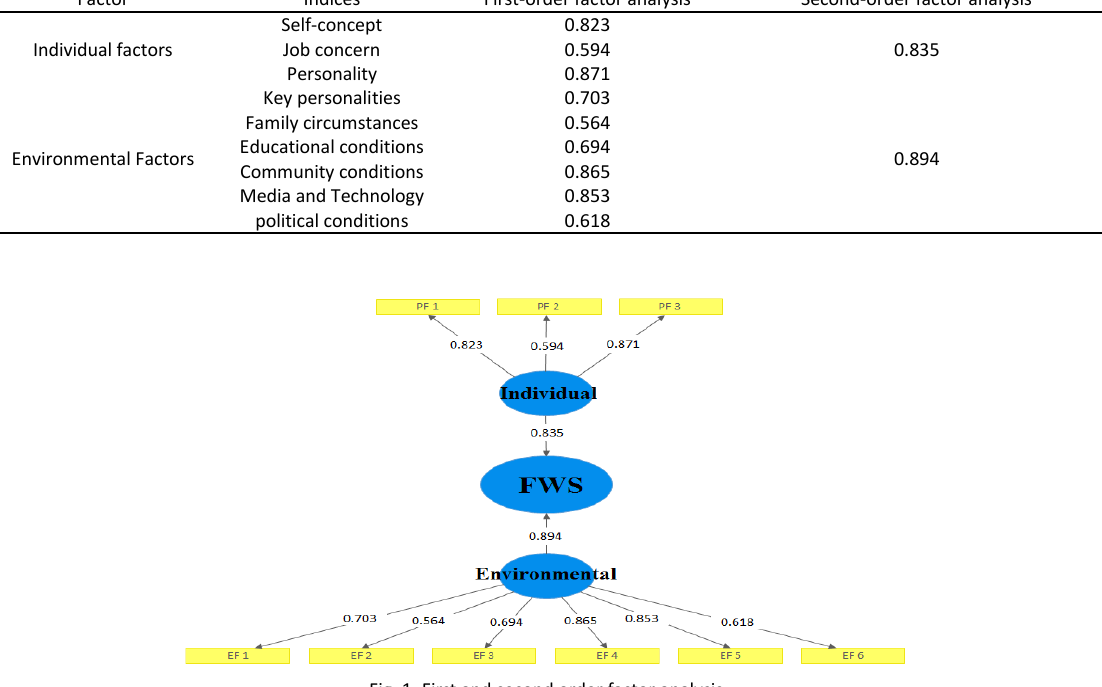
Fig. 1: First and second order factor analysis